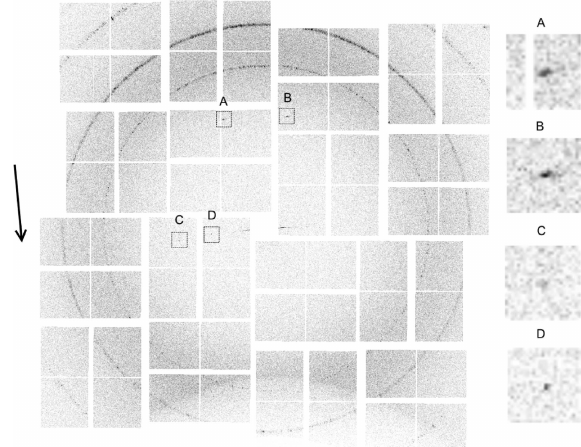
Figure 2 An example single frame, contrast enhanced, showing four diffraction peaks, with detail on the right. The rings are diffraction from the ceramic nozzle. The orientation axis is approximately vertical and the approx- imate direction of the jet flow is shown by the arrow on the left. Peaks A and B are at (cid:6) 4.7 A˚ and are close to the meridional axis. Peaks C and D are on the equatorial axis and are both to the left of the origin. The ‘jet streak’, i.e. diffraction by the water jet, is the small approximately horizontal streak close to the centre of the